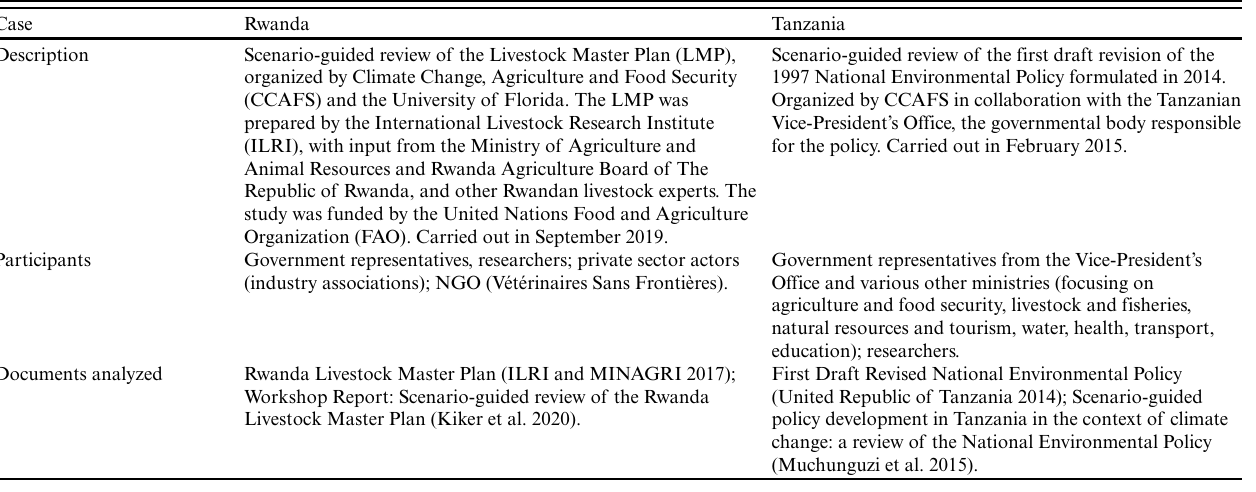
Table 2 . Case study